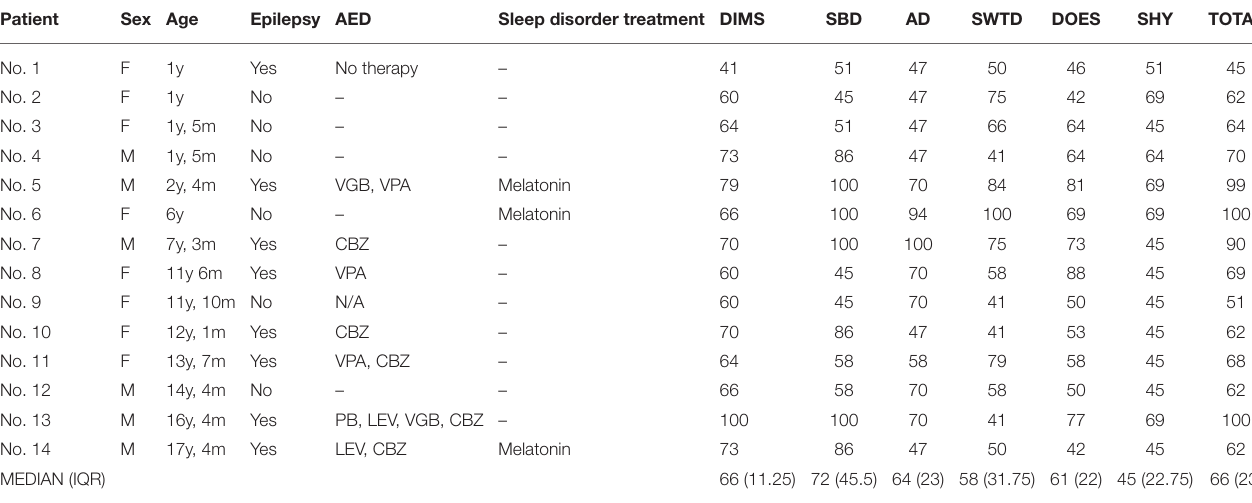
TABLE 1 | Demographic and clinical features, and SDSC results.